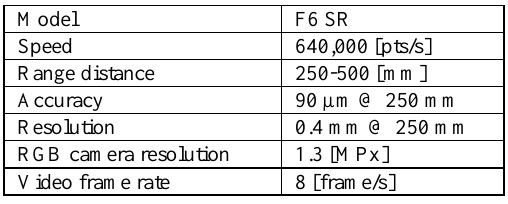
Table 2. F6 SR main specifications